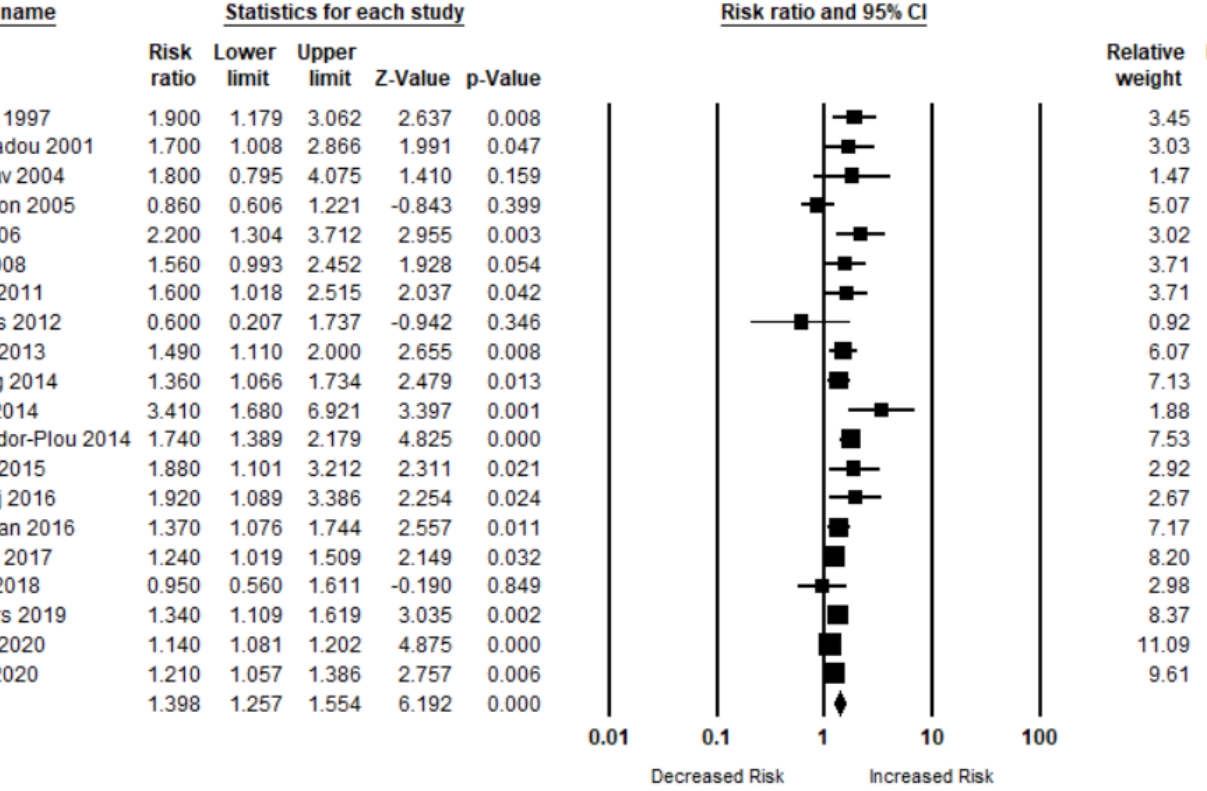
Figure 2. Association between anemia and overall cognitive impairment [6,18–36].